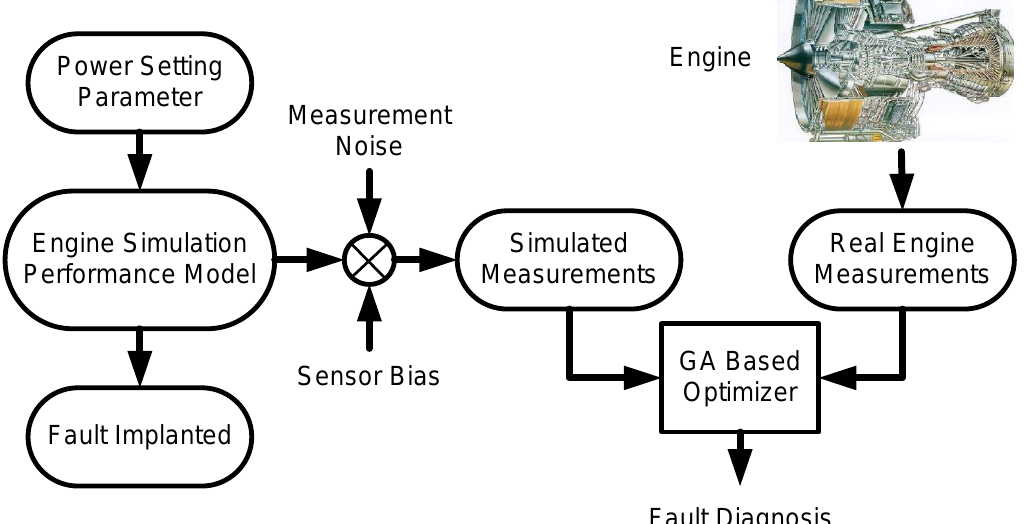
Figure 16. Schematic diagram of GA based diagnostic strategy (adapted from [203]).